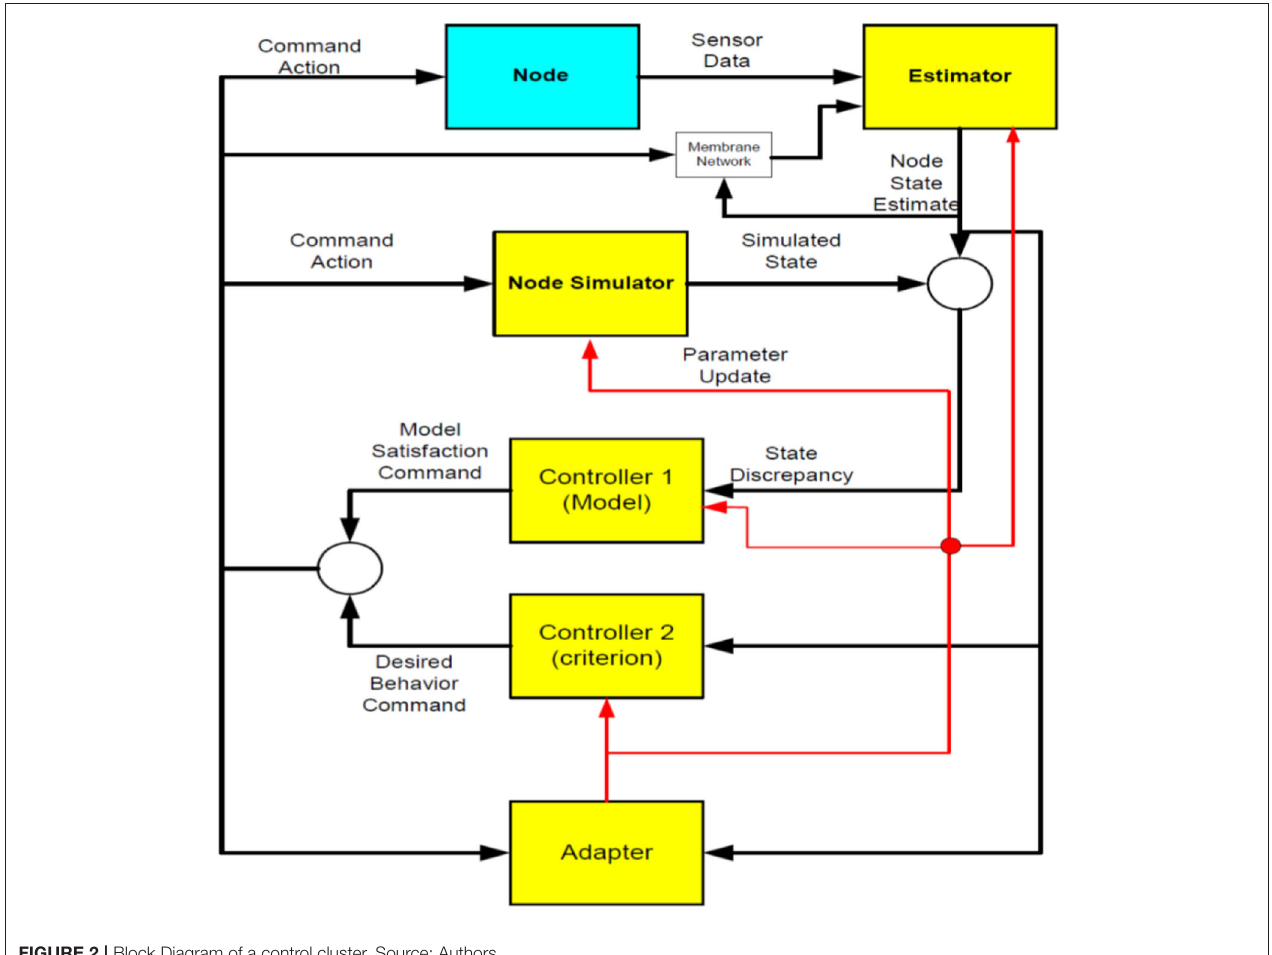
FIGURE 2 | Block Diagram of a control cluster. Source: